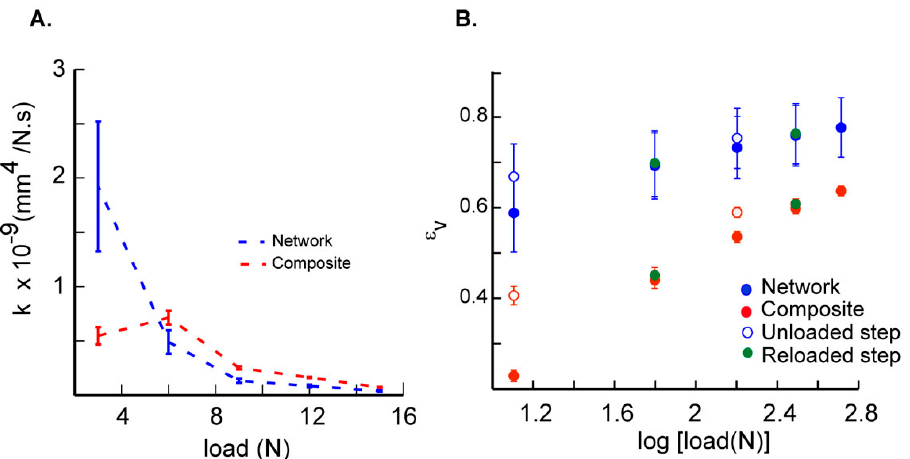
obtained and used to assess differences in the consolidation behaviours.